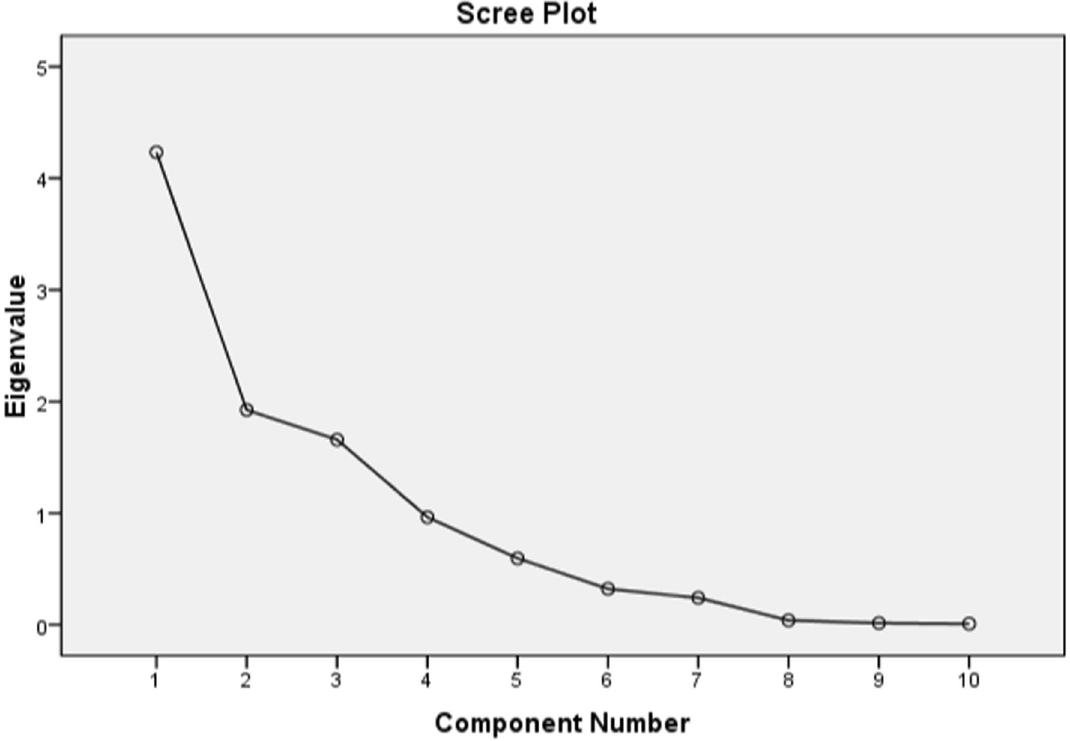
Fig. 8 Scree plot of eigen values of